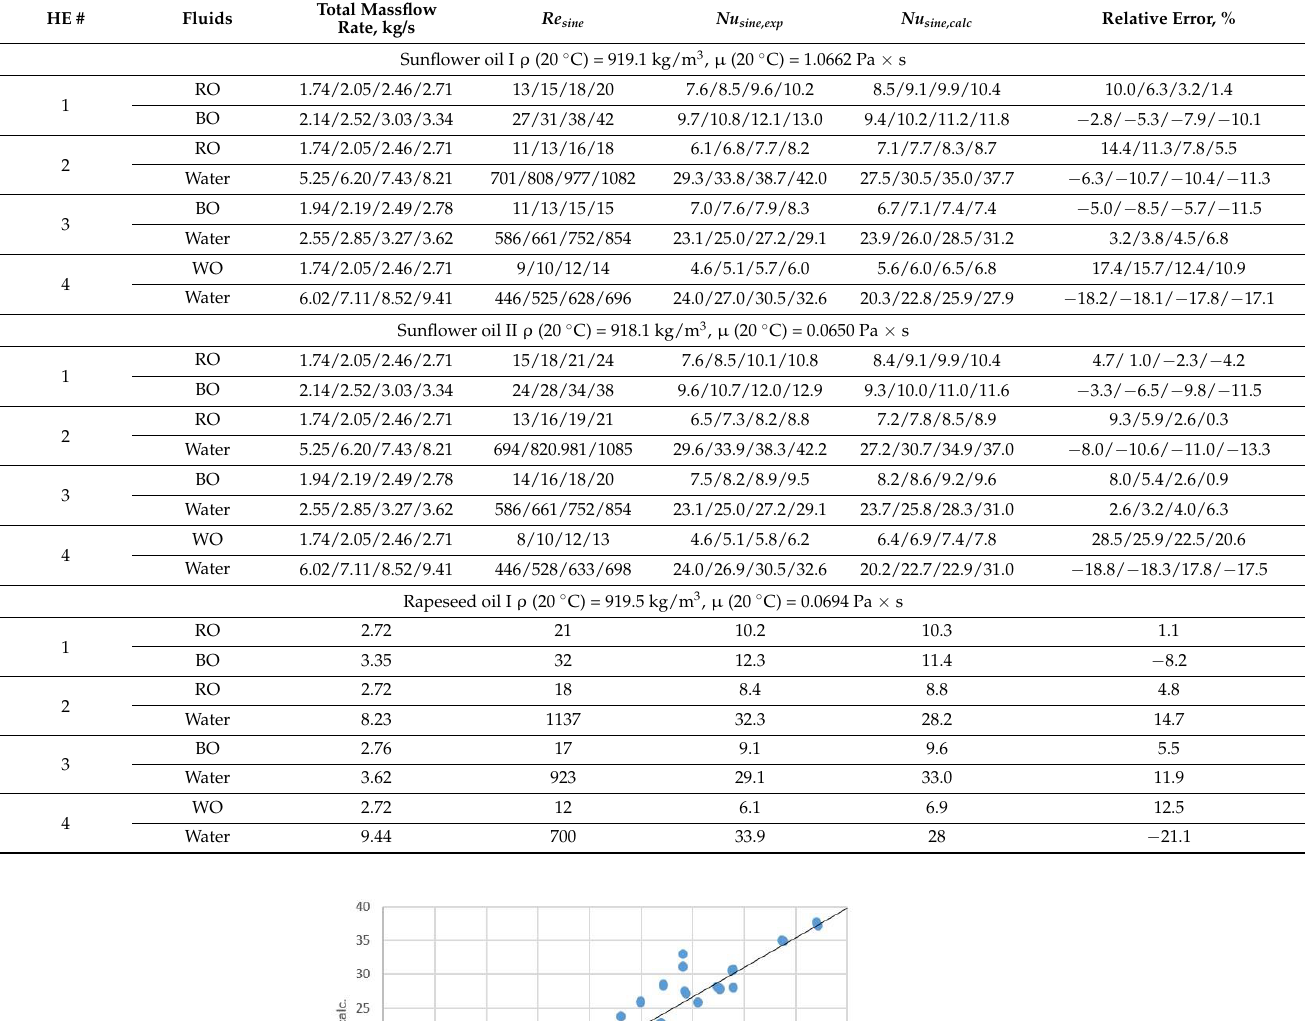
Table 6. Re sine , Nu sine,exp and Nu sine,calc related to the sine duct flow, for corrugation inclination angle 30 ◦ .